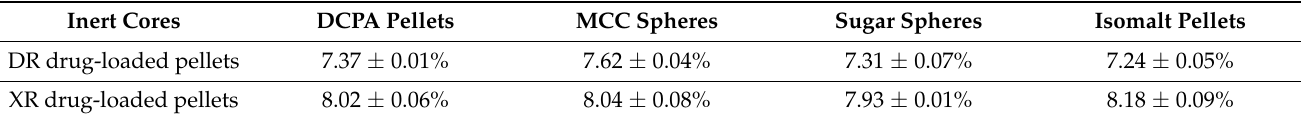
Table 4. Content of diclofenac sodium in drug-loaded pellets (mean of 3 independent determinations). Inert